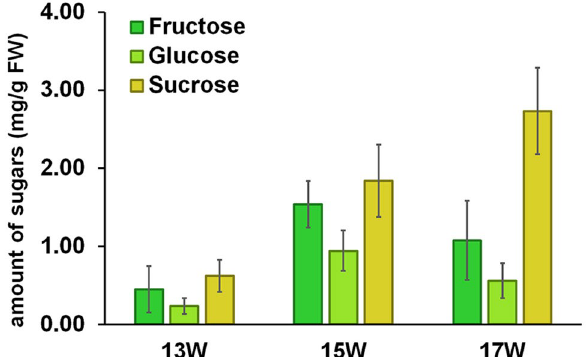
Figure 3. The amounts of three sugars, namely fructose, glucose and sucrose, in the peduncle of durian at different maturities (13, 15, and 17 weeks) as determined by HPLC-RI.